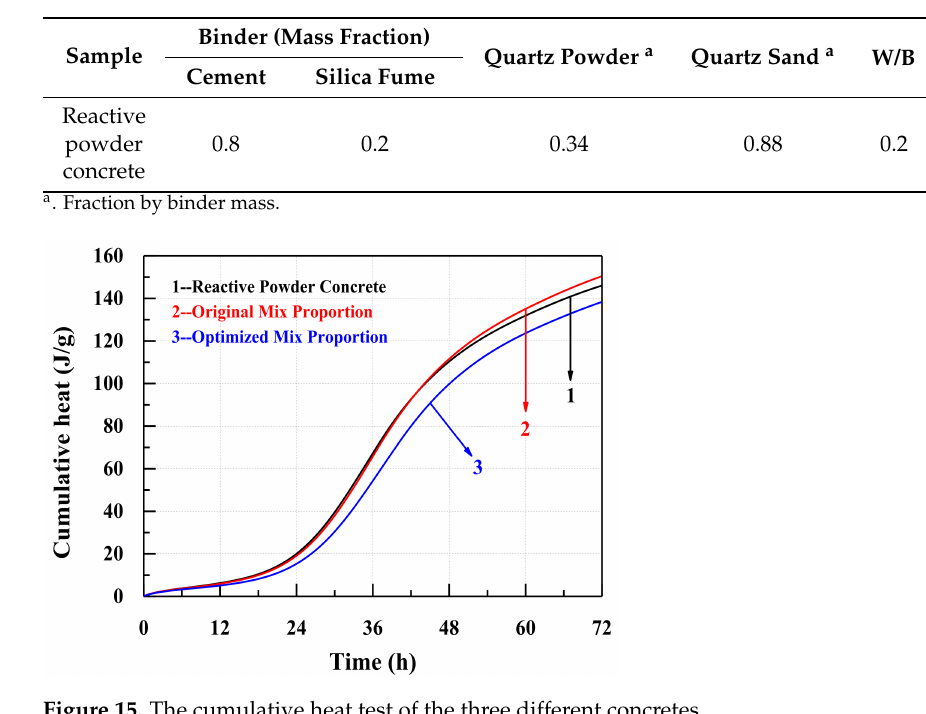
Table 9. The mix proportions of the reactive powder concrete.